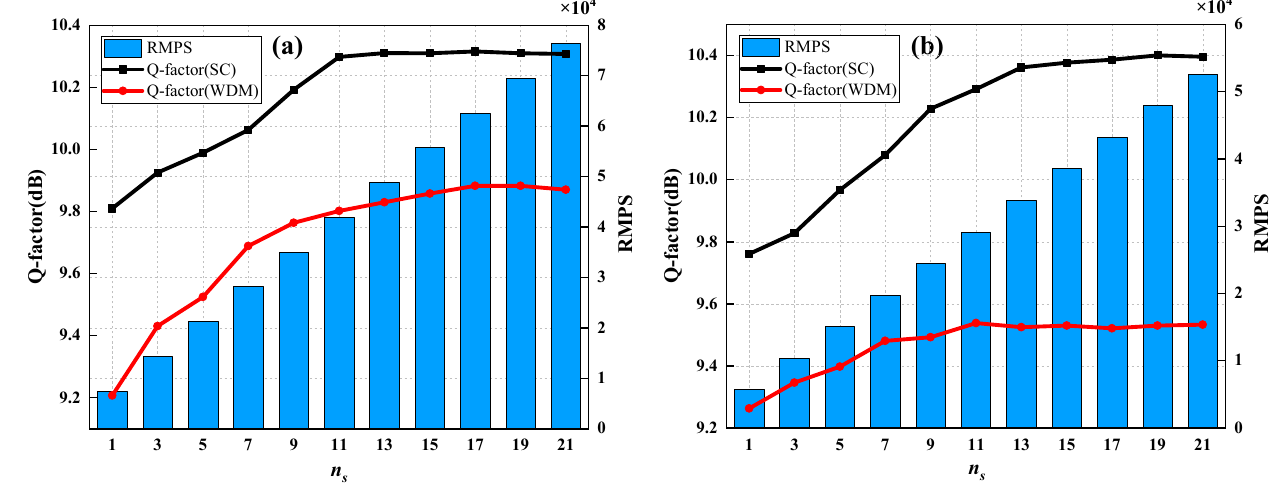
Figure 7. Q-factor versus the number of time steps n s with the corresponding RMPS. ( a ) 28 GBaud PDM-16QAM SC and 5-channel WDM systems; ( b ) 85 GBaud PDM-64QAM SC and 5-channel WDM systems.